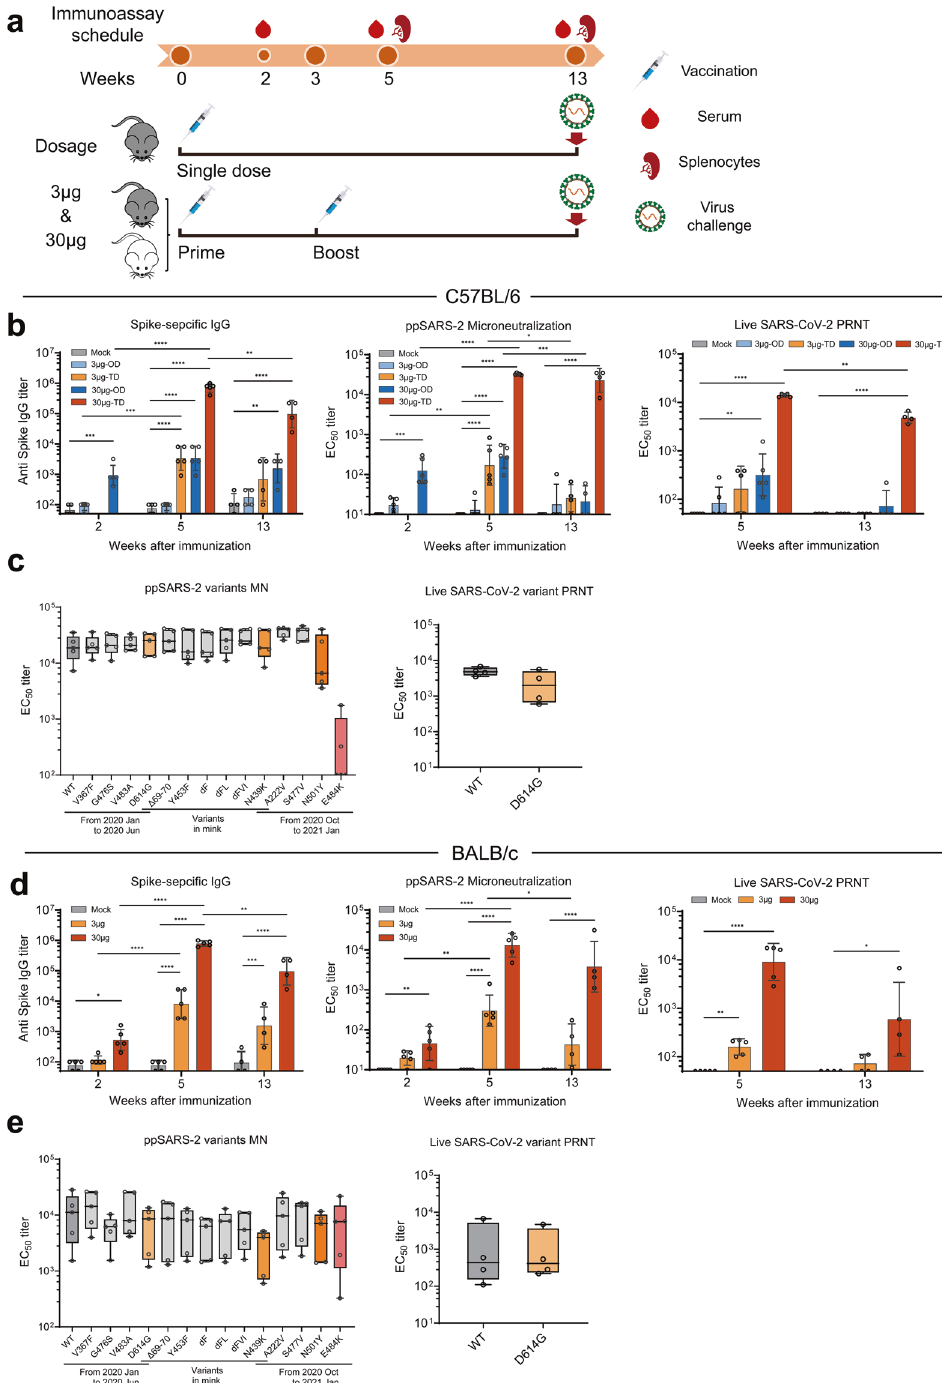
Fig. 3 Induction of robust and persistent levels of Abs with broadly neutralizing capacity by SW0123. a Two different strains of mice were used to evaluate immunogenicity and protective ef fi cacy of vaccines. C57BL/6 mice received either an one-dose (OD) vaccination with 3 or 30 μ g SW0123 (based on mRNA content) in week 0 or two-dose (TD) vaccinations with the same dosage in weeks 0 and 3. BALB/c mice were immunized twice with 3 or 30 μ g SW0123 in weeks 0 and 3. Mice in the mock group were administrated with empty vector as control. S protein-speci fi c IgG titers were measured in weeks 2, 5, and 13 using ELISA. ( n = 5 in weeks 2 and 5; n = 4 in week 13) ( b , d left panel). Neutralizing Ab (NAb) titers were measured using a SARS-CoV-2 pseudovirus microneutralization assay ( b , d mid panel) or using a live SARS- CoV-2 (Wuhan/IVDC-HB-01/2019) plaque reduction neutralizaion test ( b , d right panel). NAb titers are shown as EC50 values, calculated by Reed-Muench method. c , e Serum collected at week 5 from two-dose SW0123-immunized mice ( n = 5 for each strain) were tested for neutralizing ability against pseudotype SARS-CoV-2 with indicated mutation points in S protein or were tested against live D614G mutant and wide-type strain (Wuhan/IVDC-HB-01/2019) using plaque reduction neutralization test. Two-tailed Mann – Whitney test was used for statistical analysis. * p ≤ 0.05; ** p < 0.01; *** p < 0.001; **** p < 0.0001